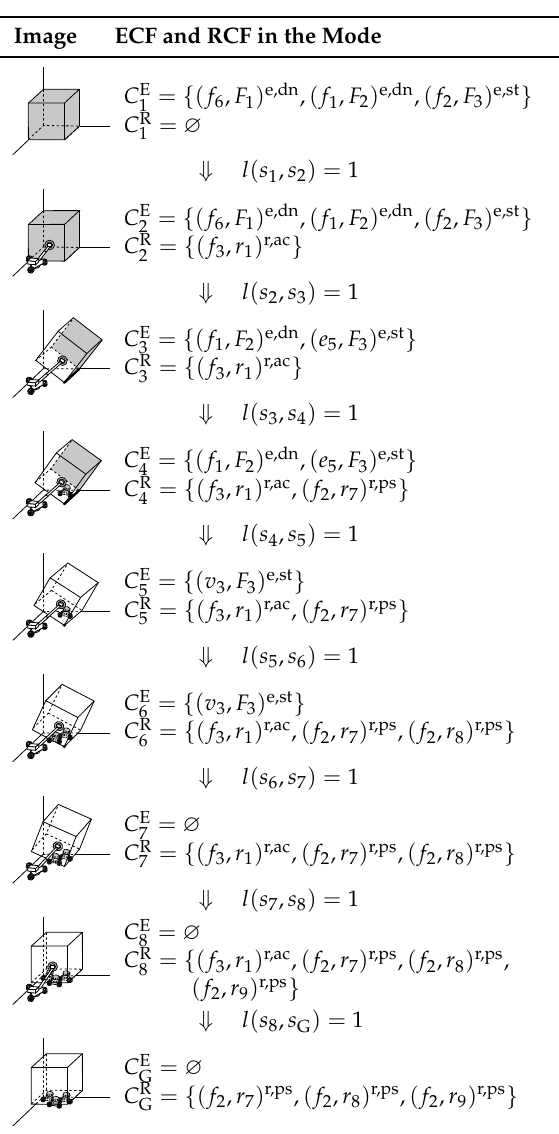
Table 2. One of the manipulation paths that minimized the cost.